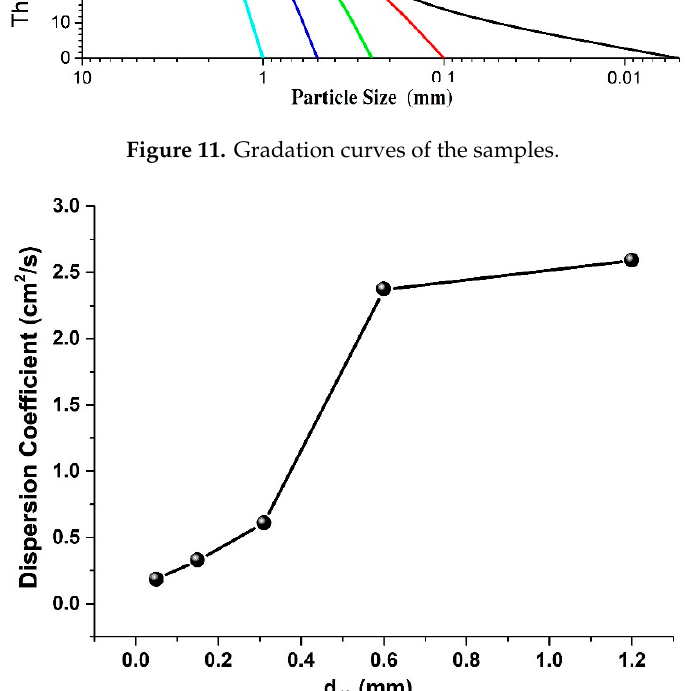
Figure 12. One-dimensional dispersion coefficients of samples with different gradations .